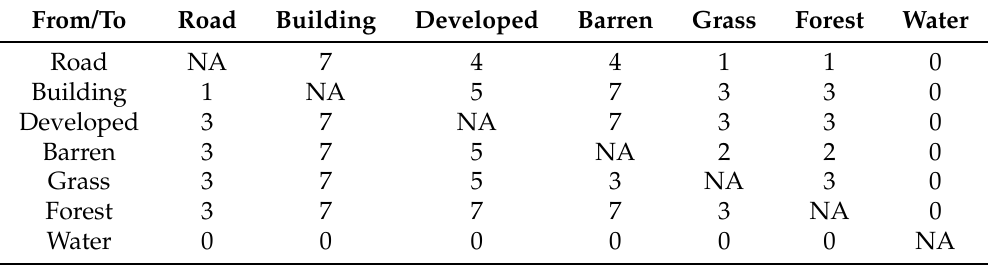
Table 4. Priority Change